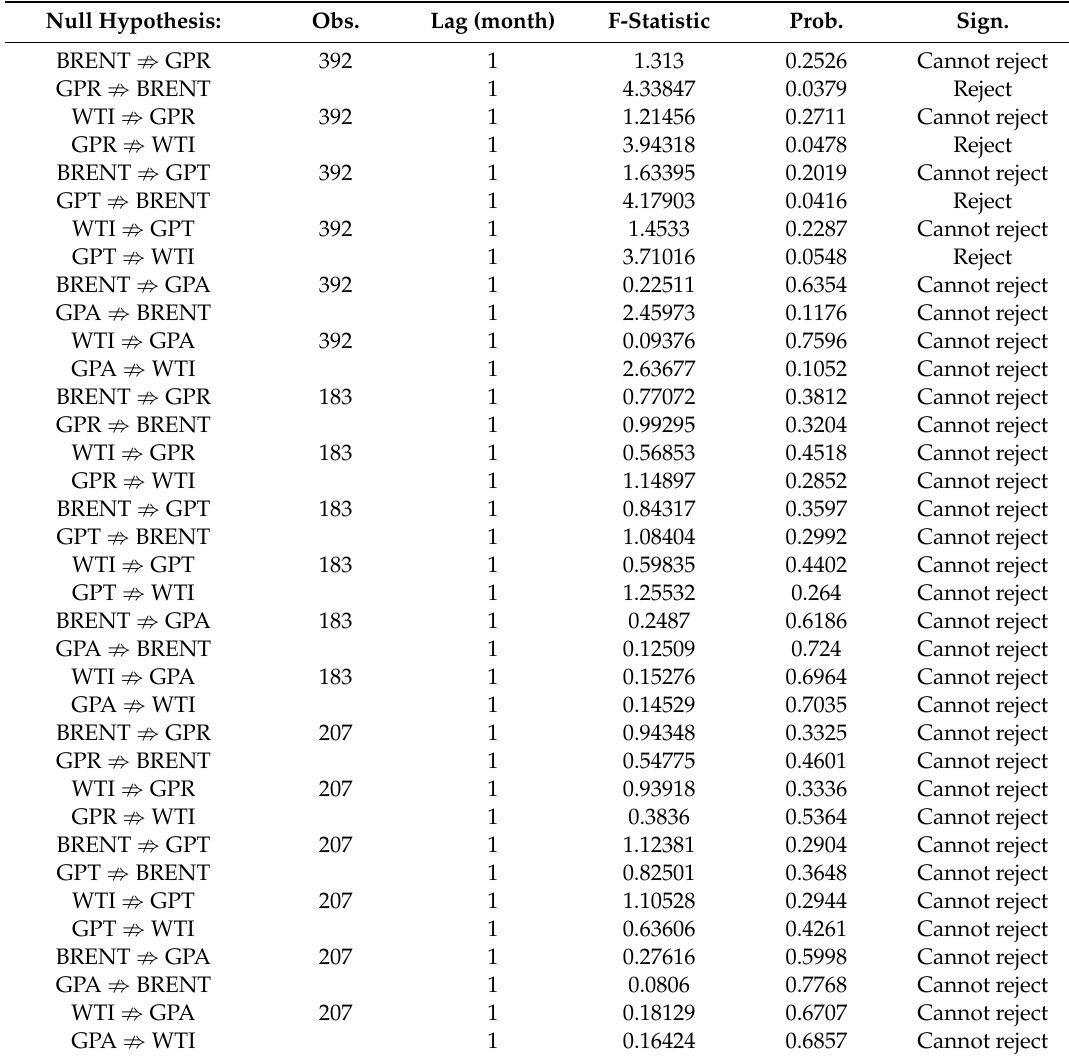
Table 3. Results of Granger causality test with first-order